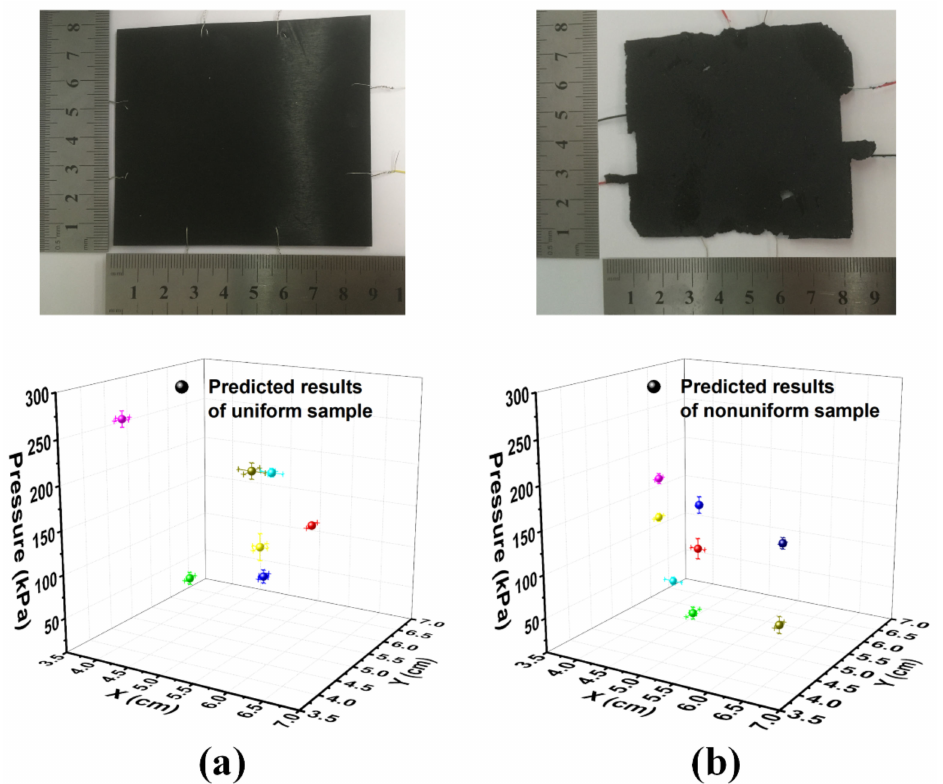
Figure 8. The photos and the predicted results of ( a ) the uniform sample and ( b ) the nonuniform sample. The error bars in the figure indicate the deviation between the predicted results and the measured